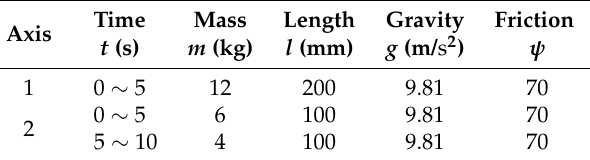
Table A1. System parameters for simulation